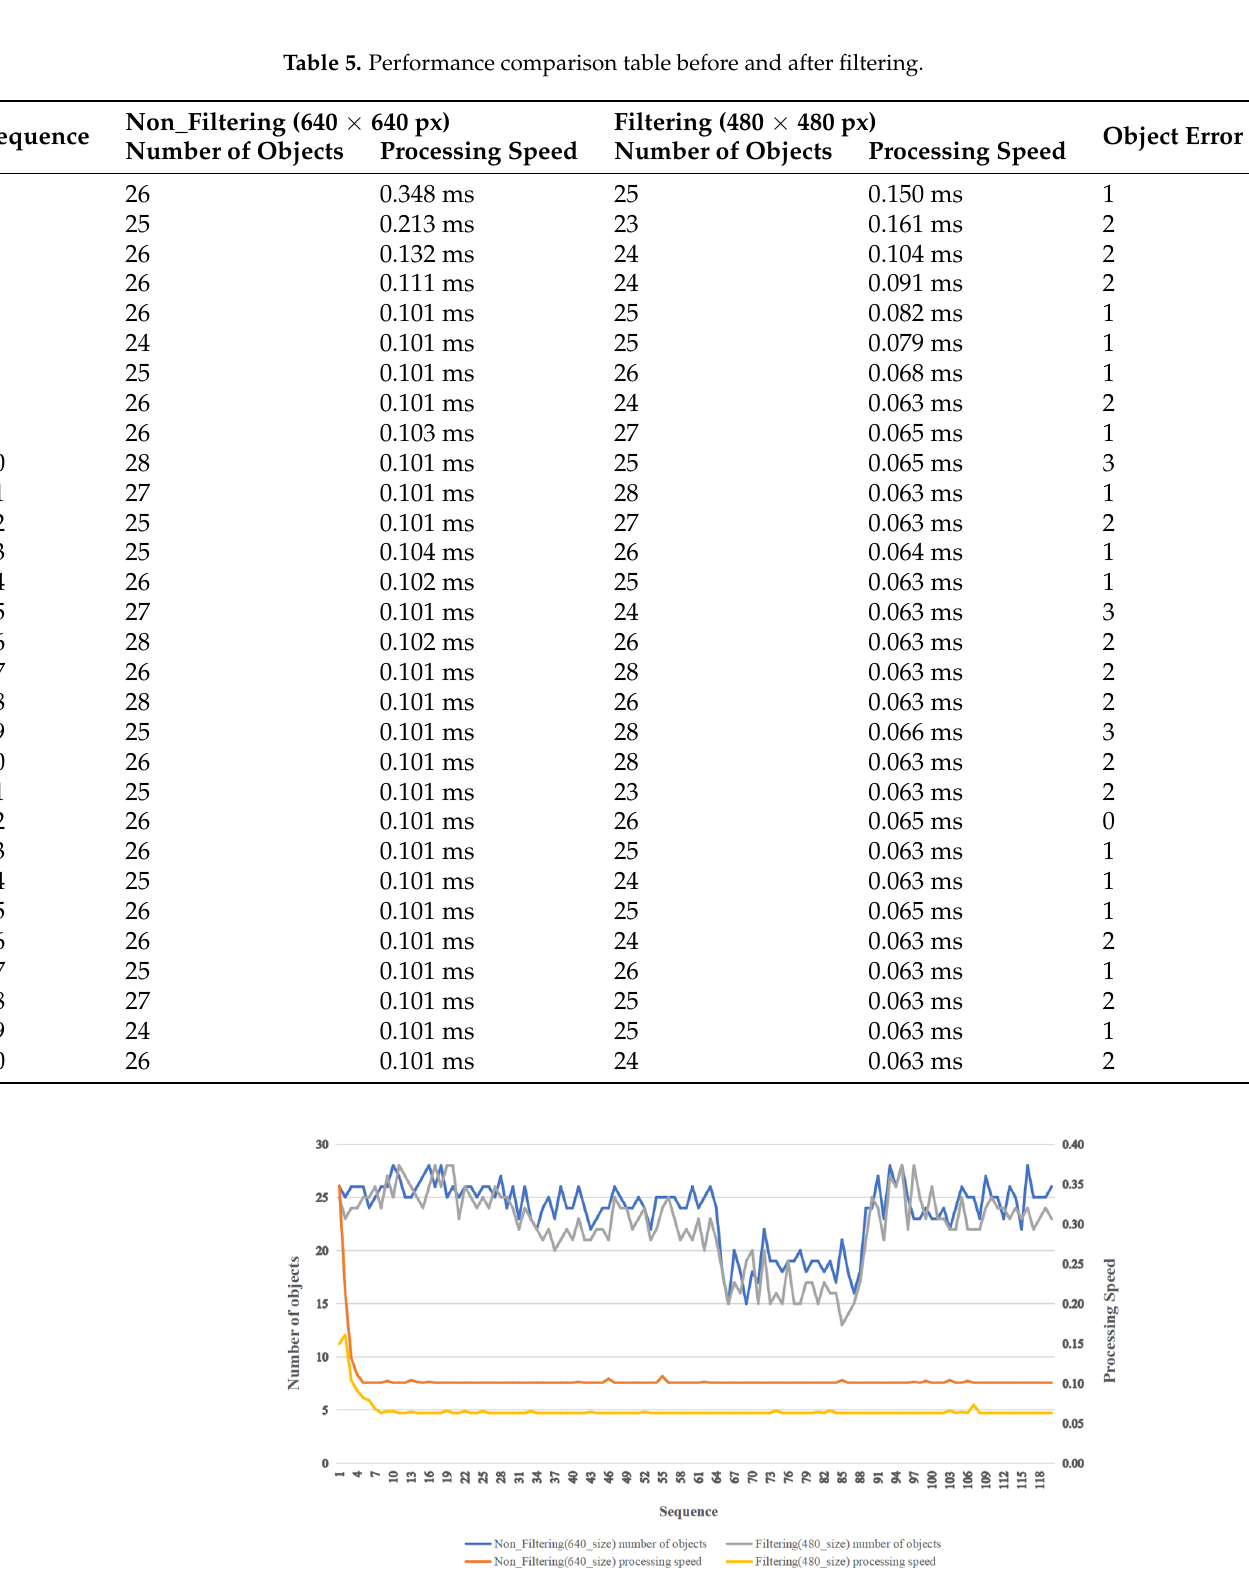
Figure 11. Comparison results before and after filtering. The experimental results show a significant increase in the speed of object detection. We can quickly boost the speed of detection and create avoidance routes in real-time by employing our